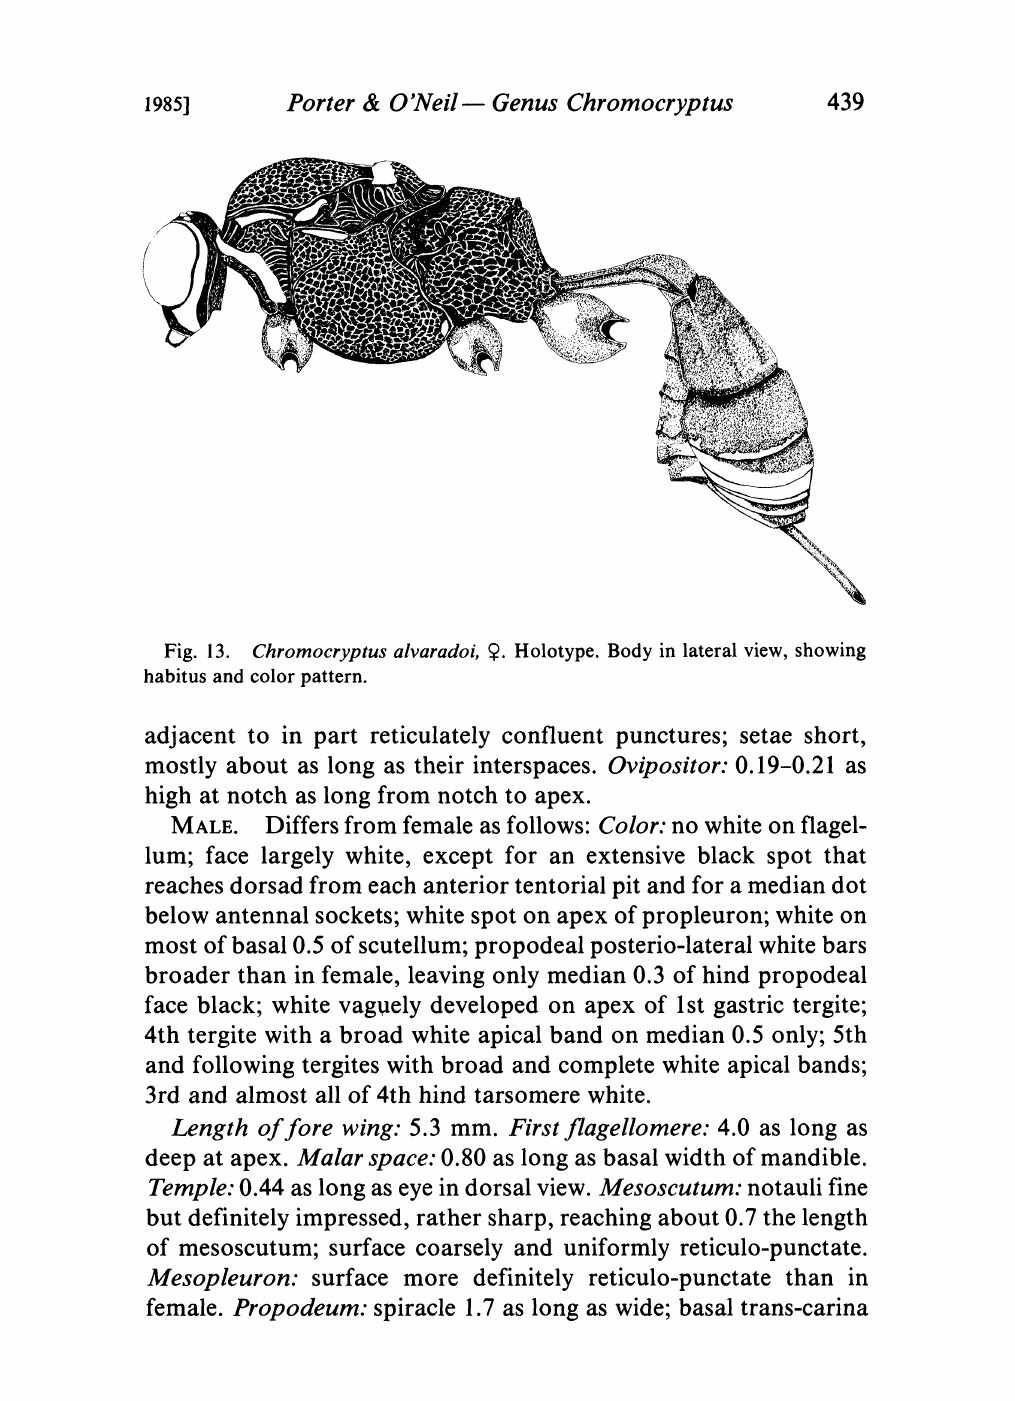
.. Holotype. Body in lateral view, showing